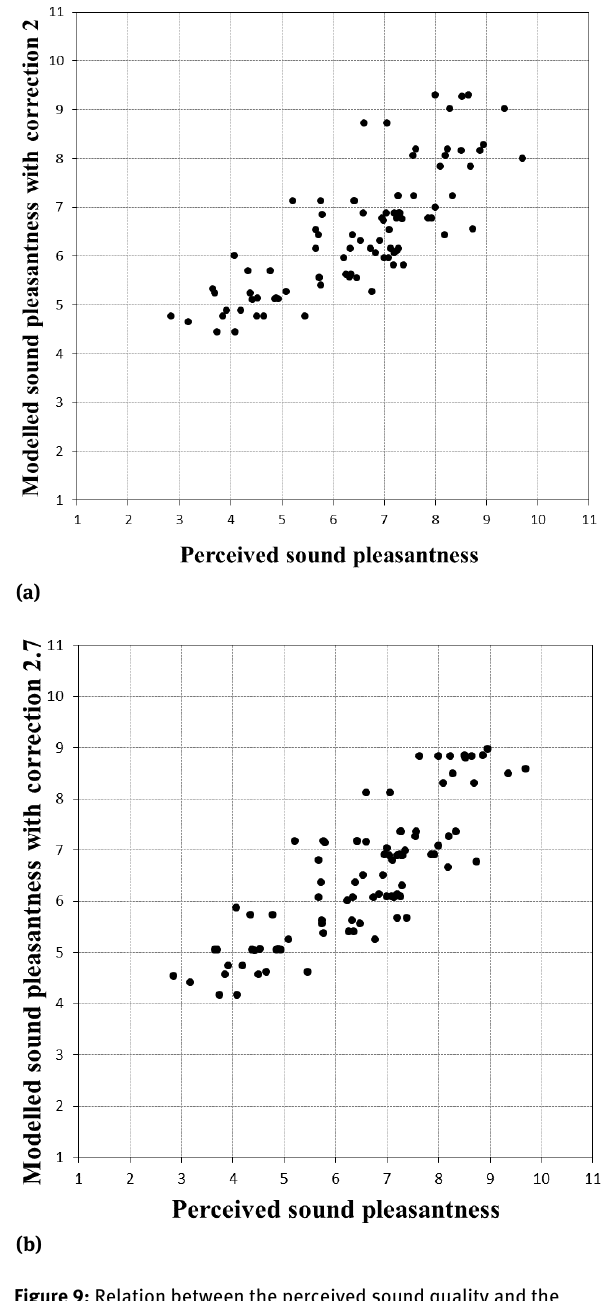
Figure 9: Relation between the perceived sound quality and the sound quality modelled by the Eq. 14 (9a) and Eq. 15